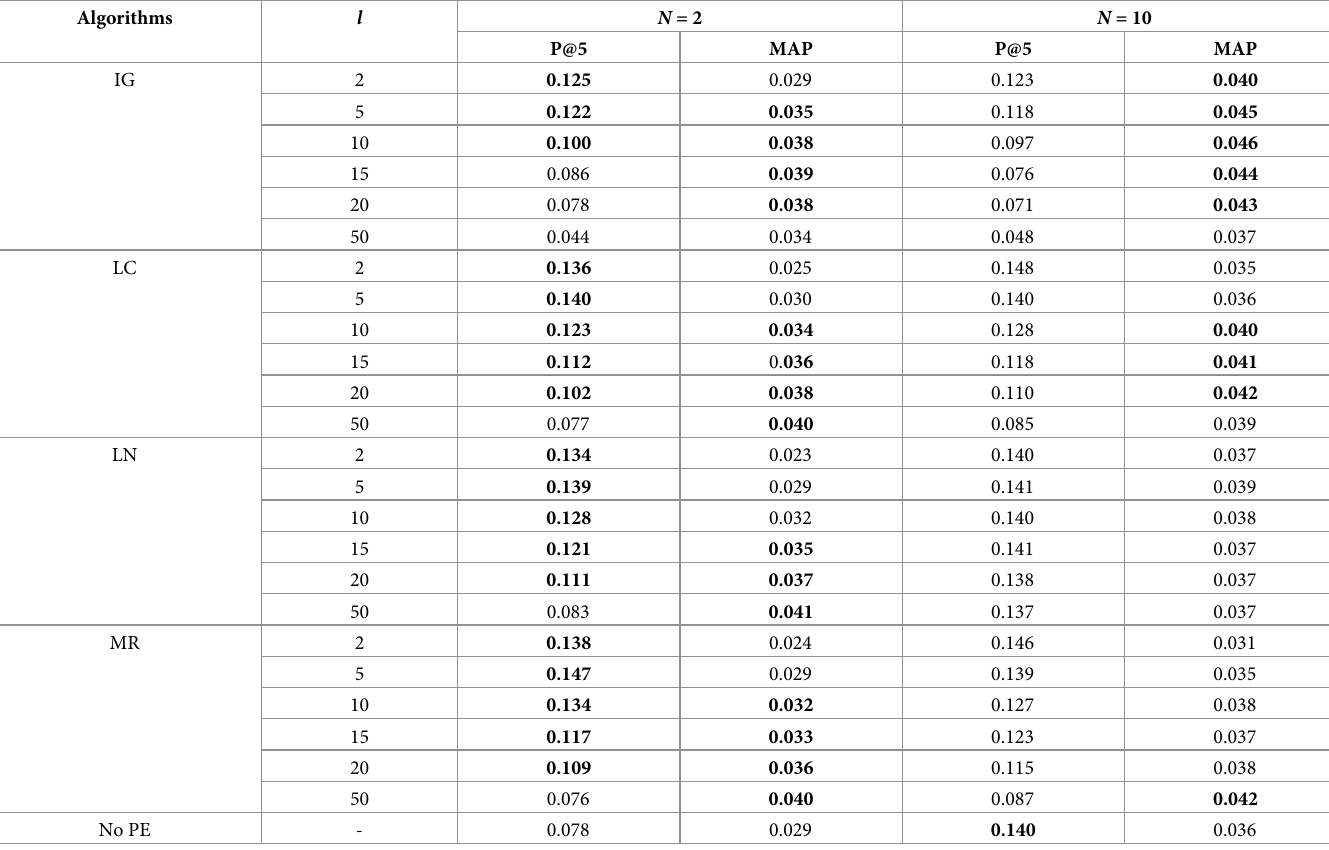
Table 1. P@5 and MAP for Profile Expansion baseline algorithms. Significant improvements over the algorithm without PE are highlighted. Algorithms